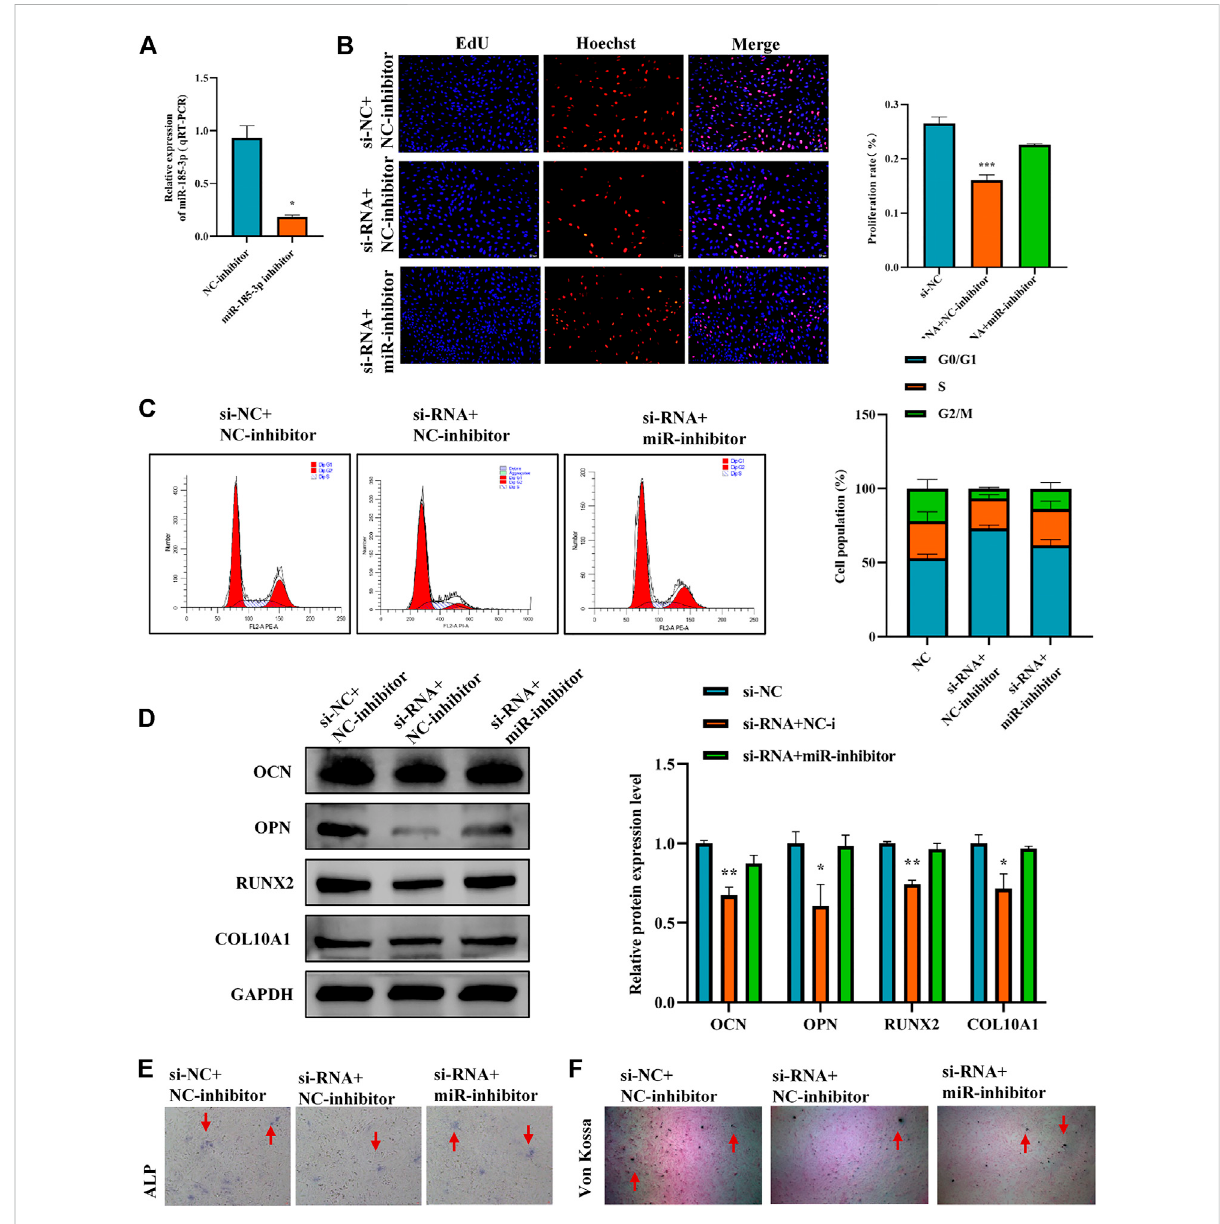
FIGURE 5 Hsa_circ_0008870 suppresses chondrocytes growth and proliferation and cartilageosteogenesis bytargeted upregulation ofmiR-185-3p. (A) The RNA levels of miR-185-3p in human chondrocytes transfected with miR-185-3p inhibitor were measured by RT-qPCR. (B) Proliferation of chondrocytes downregulated by hsa_circ_0008870 was detected by Edu assays, with or without miR-185-3p inhibitor. (C) The effect of hsa_circ_0008870 downregulation on chondrocyte cell cycle was detected by fl ow cytometry, with or without miR-185-3p inhibitor. (D) The protein expressions of OCN, OPN, RUNX2 and collagen type X were measured in hsa_circ_0008870 knockdown chondrocytes, with or without miR-185-3p inhibitor. (E) ALP activity was measured in hsa_circ_0008870 knockdown chondrocytes, with or without miR-185-3p inhibitor. (F) Von Kossa staining demonstrated changes in mineralization in hsa_circ_0008870 knockdown chondrocytes, with or without miR-185-3p inhibitor. P